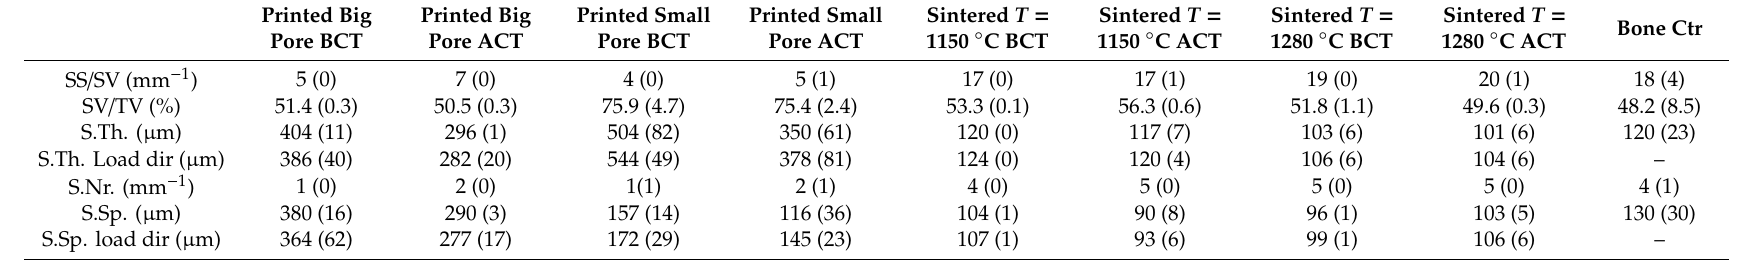
Table 1. Morphometric analysis of microCT data, as measured in the di ff erent biomaterials before and after compressive tests. Bone control (ctr) parameters were obtained as mean between four di ff erent healthy jawbones, two in maxillary and two in mandibular human sites. Mean (SD); BCT: Before compressive test; ACT: After compressive